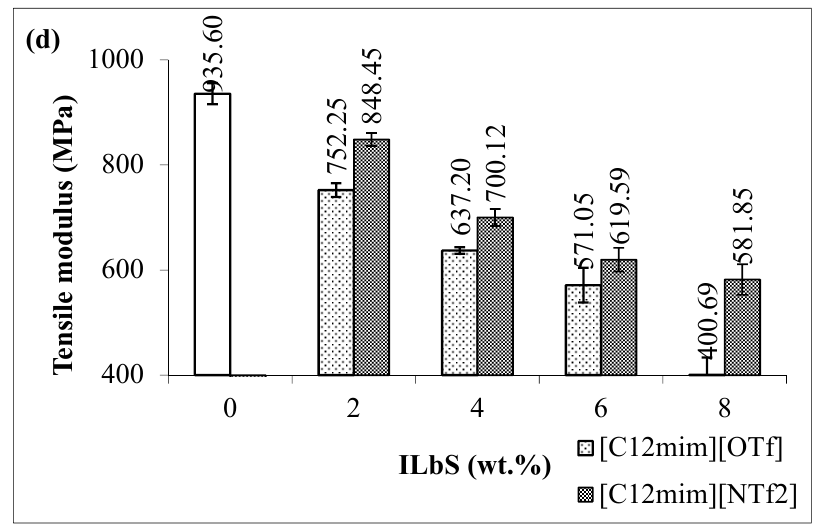
Figure 1. ( a ) Tensile extension, ( b ) tensile energy, ( c ) tensile stress and ( d ) tensile modulus at maximum Figure 1. (a) Tensile extension, (b) tensile energy, (c) tensile stress and (d) tensile modulus at load of the PBS / RS blends without and with di ff erent contents and types of ILbS. maximum load of the PBS/RS blends without and with different contents and types of ILbS. Table 1. ANOVA result of the tensile extension of the PBS/RS blends without and with containing Table 1. ANOVA result of the tensile extension of the PBS / RS blends without and with containing ILbS. ILbS. Source of Variation SS df MS P -Value BG SS = sum of square, df = degree of freedom, MS = mean square, F = F-value, Number of samples = 3, Number of observations = 30. Table 2. ANOVA result of the tensile energy of the PBS / RS blends without and with containing ILbS. Table 2. ANOVA result of the tensile energy of the PBS/RS blends without and with containing ILbS. Source of Variation SS df MS F P Source of Variation